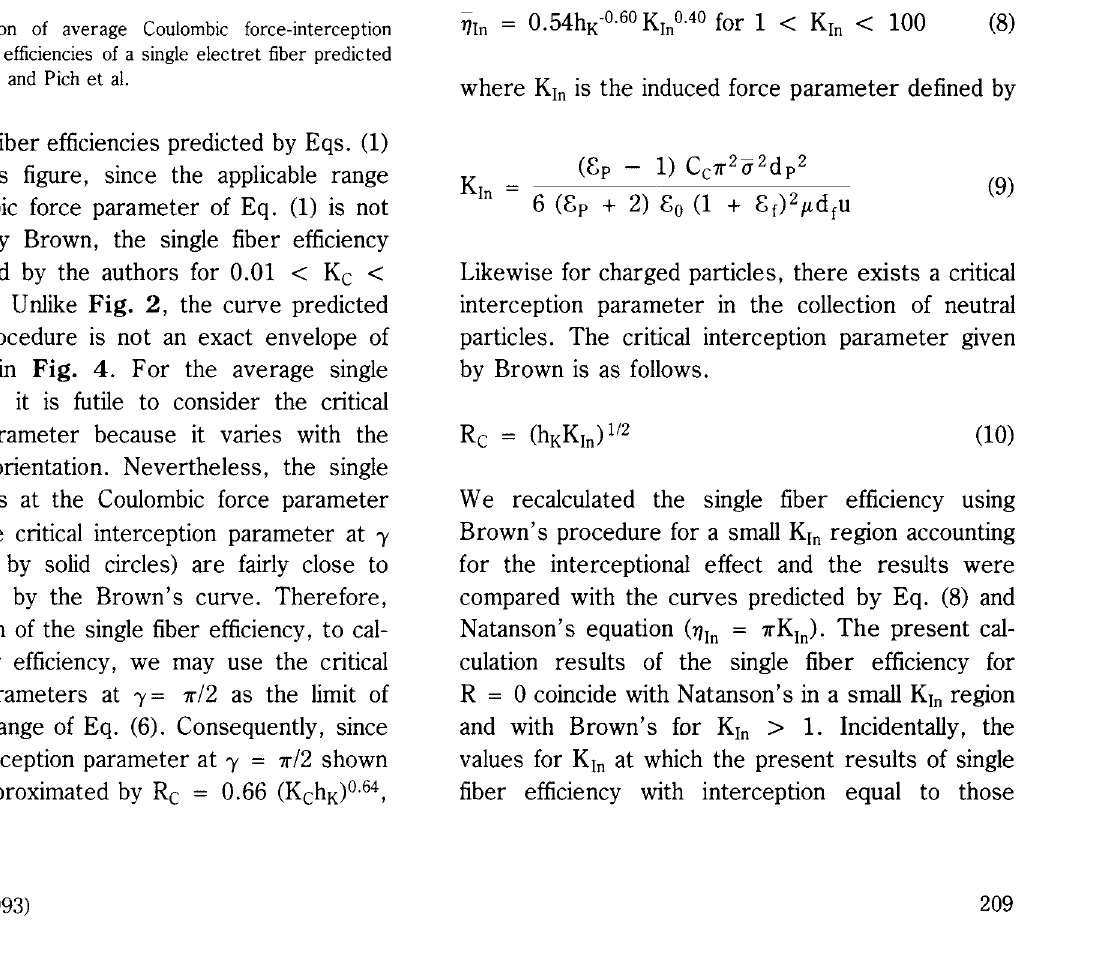
Comparison of average Coulombic